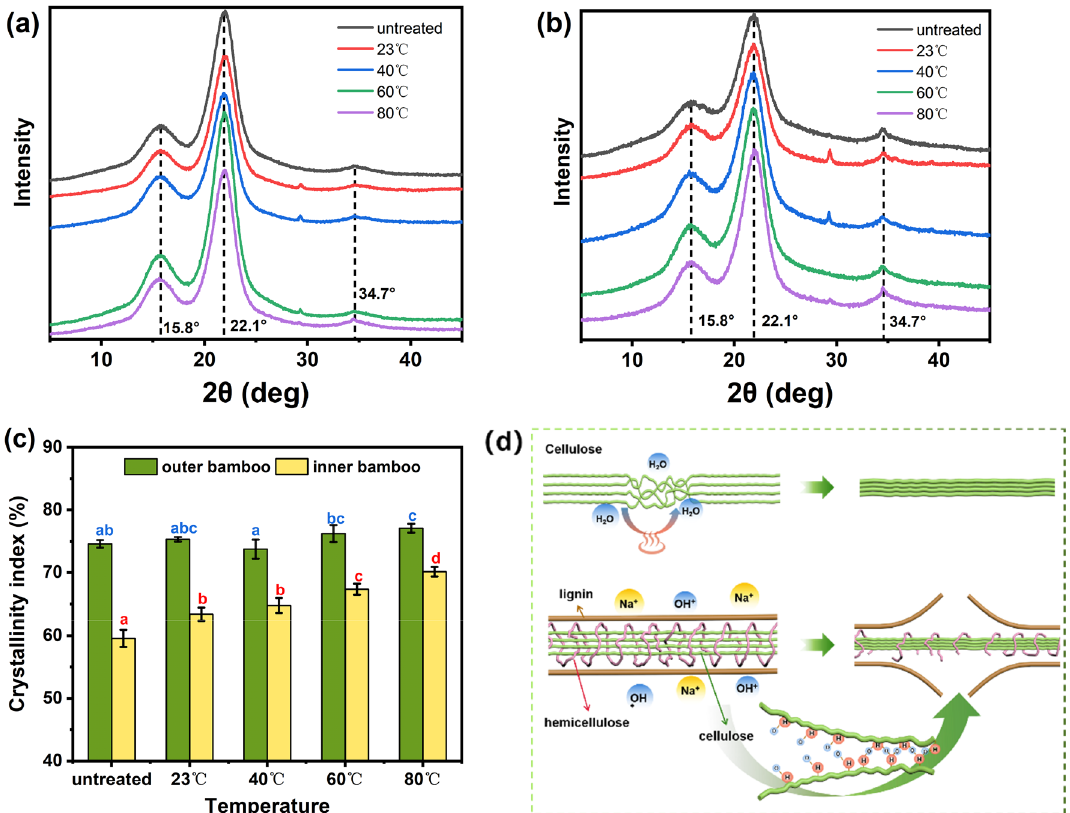
Fig. 4 XRD patterns and crystalline index of cellulose in alkali-treated bamboo slivers with different temperatures. a Outer bamboo silver; b inner bamboo sliver; c crystallinity index of bamboo slivers; d schematic diagram of crystallinity